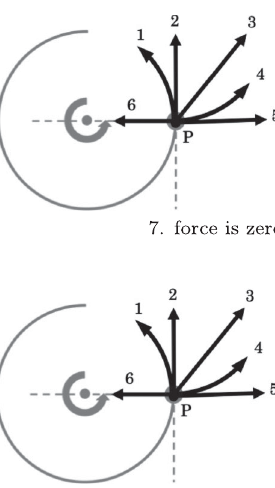
FIG. 2 (color online). Q.7 of the FCI.